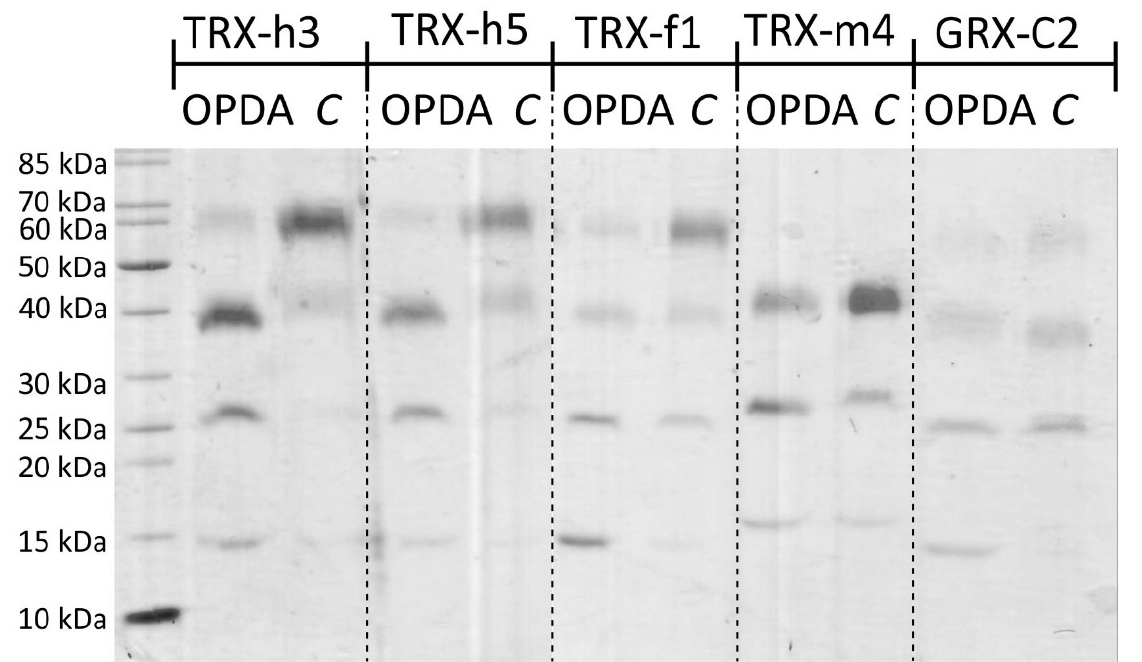
Figure 1. Blocking of exposed thiols of TRXs and GRXC2 by OPDA as indicated by less mPEGmal binding. Recombinant TRX-h3, TRX-h5, TRX-f1, TRX-m4 and GRX-C2 were reduced and desalted, and either treated with 150 µ M OPDA or the equivalent amount of the solvent ethanol (“ C ”). Samples were treated with mPEG-maleimide 5000 to label free thiols. Shifts to increased apparent molecular mass indicates thiol accessibility for modification, while the lack of shifts indicates inaccessibility of thiols after treatment with OPDA. Similar results were seen in 4 experiments. Band quantification is presented in Supplementary Figure S1.